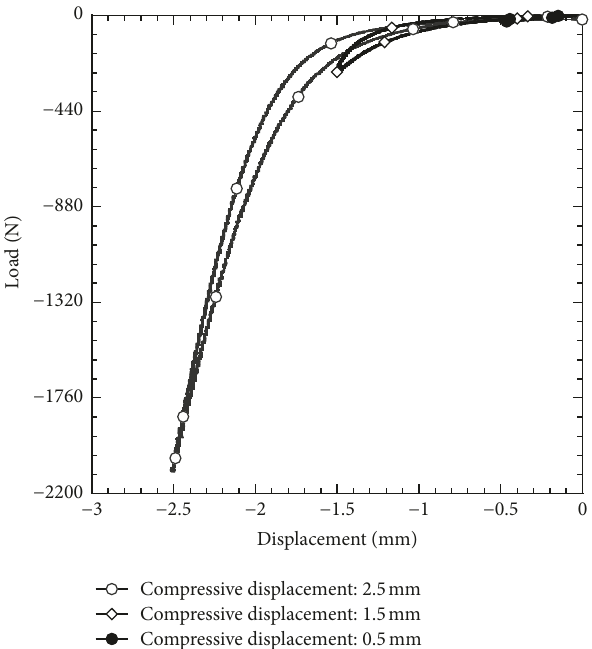
Figure2:Representativeload-displacementrelationshipsforaSMA mesh washer along thickness direction [21].